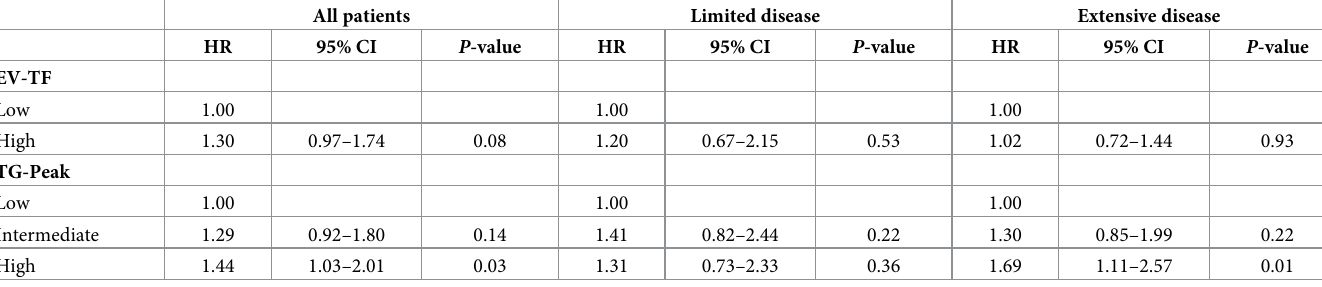
Table 4. Mortality ratios vs biomarker levels at baseline, for all patients and by disease stage.